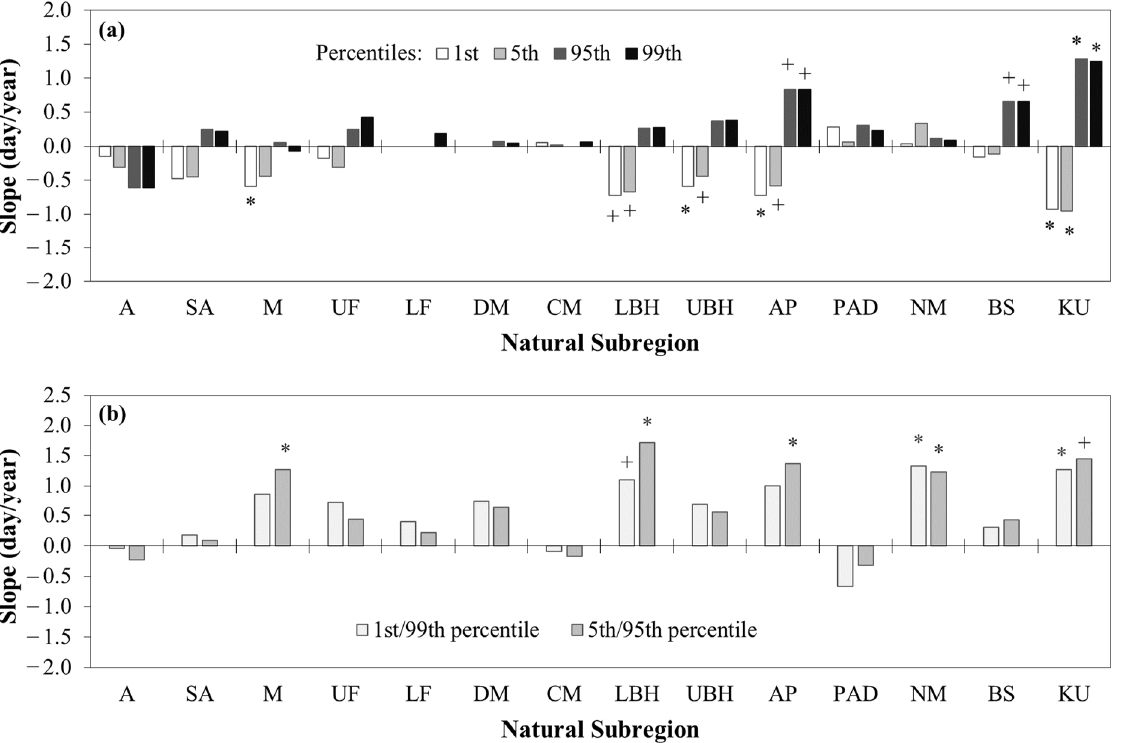
Figure 5. Trends of the forest fire season in the natural subregions of Alberta over the period 1959 ‒ 2021 with significance levels of 99% (*) and 95% ( + ). Slopes (day/year) of fire season start and end dates ( a ), and length ( b ) were determined using 1st and 99th, and 5th and 95th percentiles.